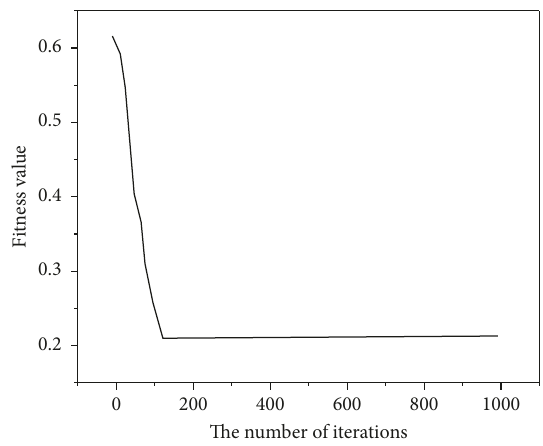
Figure 5: Particle iteration diagram for working condition 3. Table 4: Damage identification results for condition 3 (part).